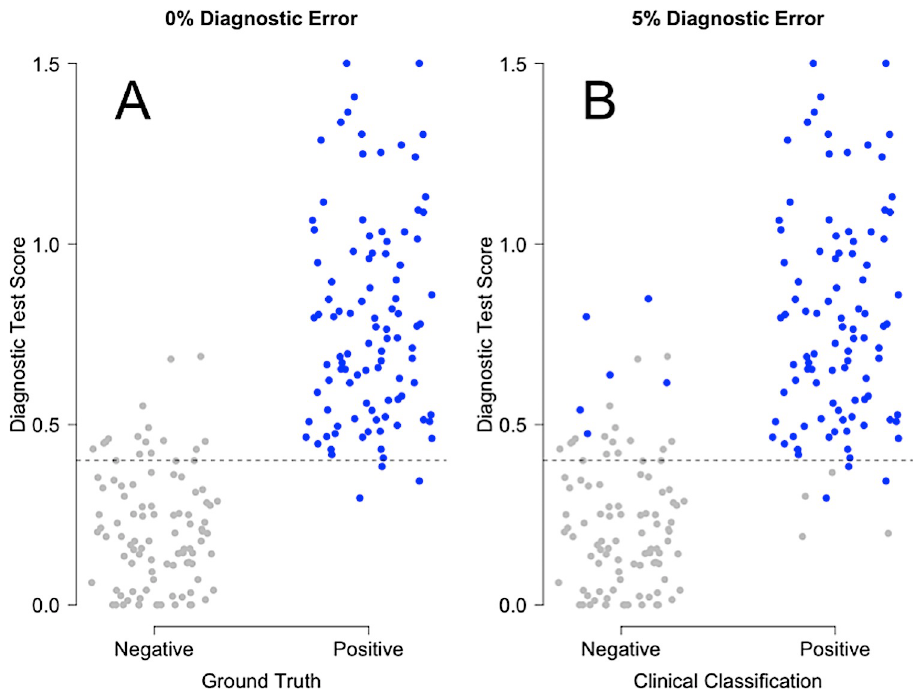
A, there is no error in patient classification (i.e. the comparator is perfectly concordant with the Ground Truth). In Panel B, a random 5% of the comparator’s classifications are assumed to diverge incorrectly from the Ground Truth. The difference in the distribution of test scores (y-axis) between the panels of this figure results in significant underestimates of diagnostic performance as shown in Table 1.